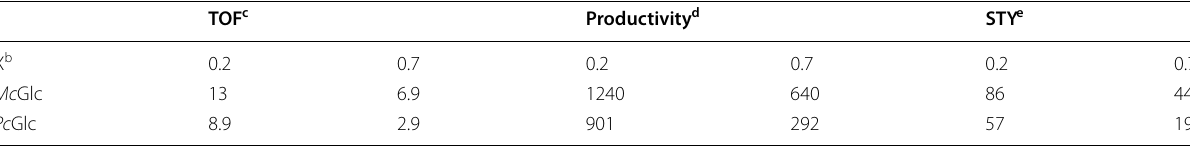
Table 3 Performance of Mc Glc and Pc Glc in optimized transglycosylation reactions at low and high conversions with dissolved 2 and 2-phenylethanol a